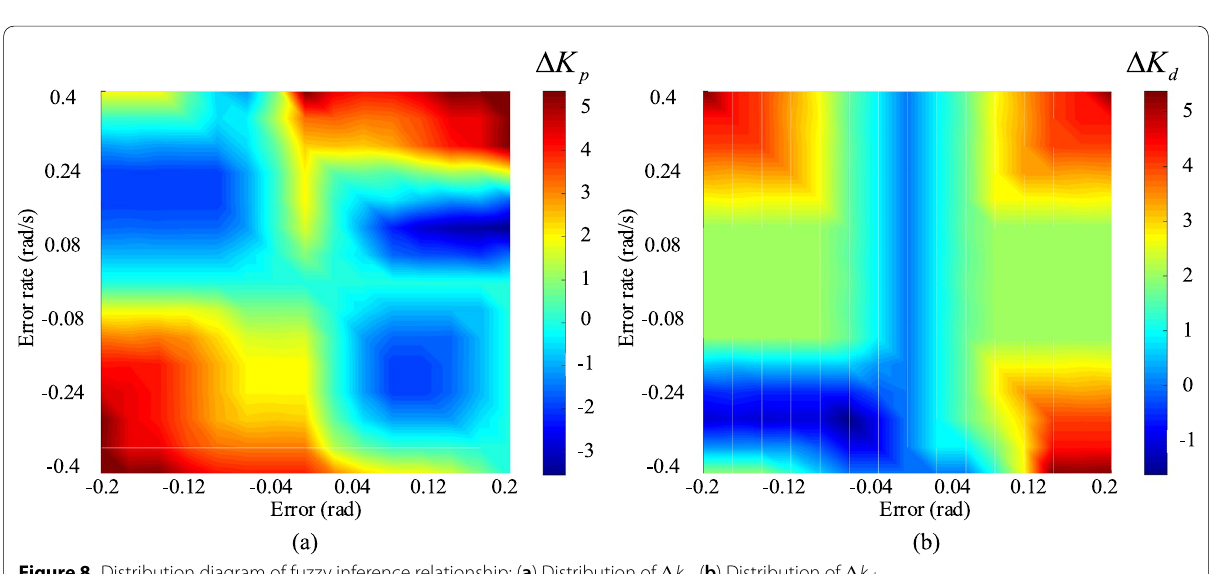
Figure 8 Distribution diagram of fuzzy inference relationship: ( a ) Distribution of (cid:31) k p , ( b ) Distribution of (cid:31) k